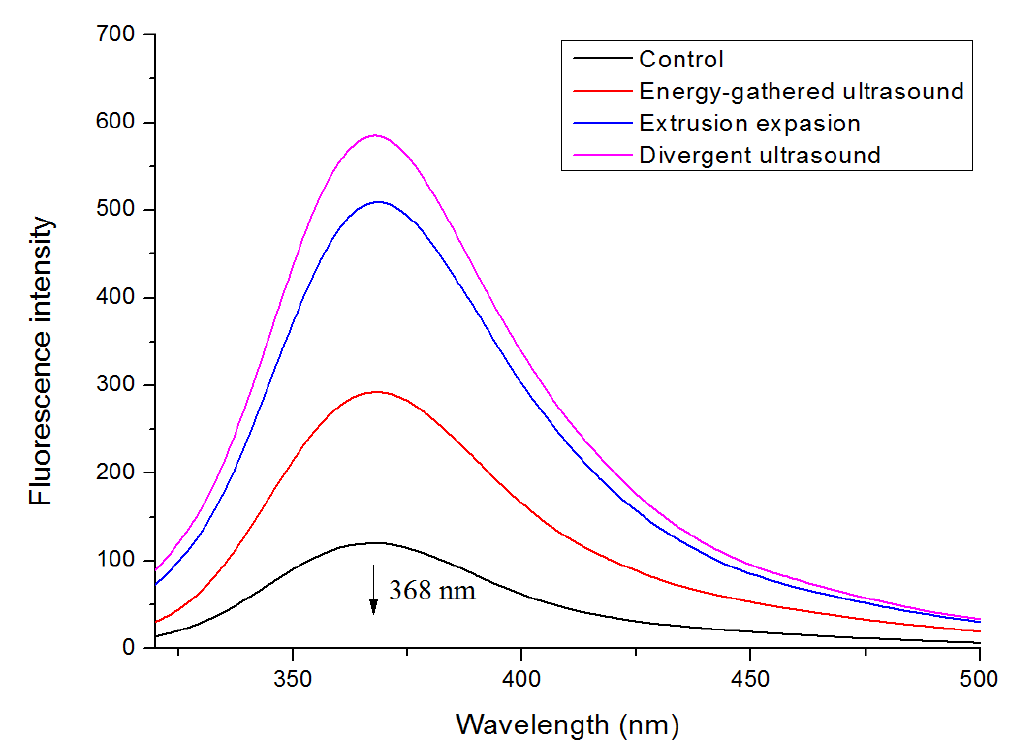
Figure 6. Intrinsic fluorescence emission spectra of proteins subjected to different ultrasound pretreatments.